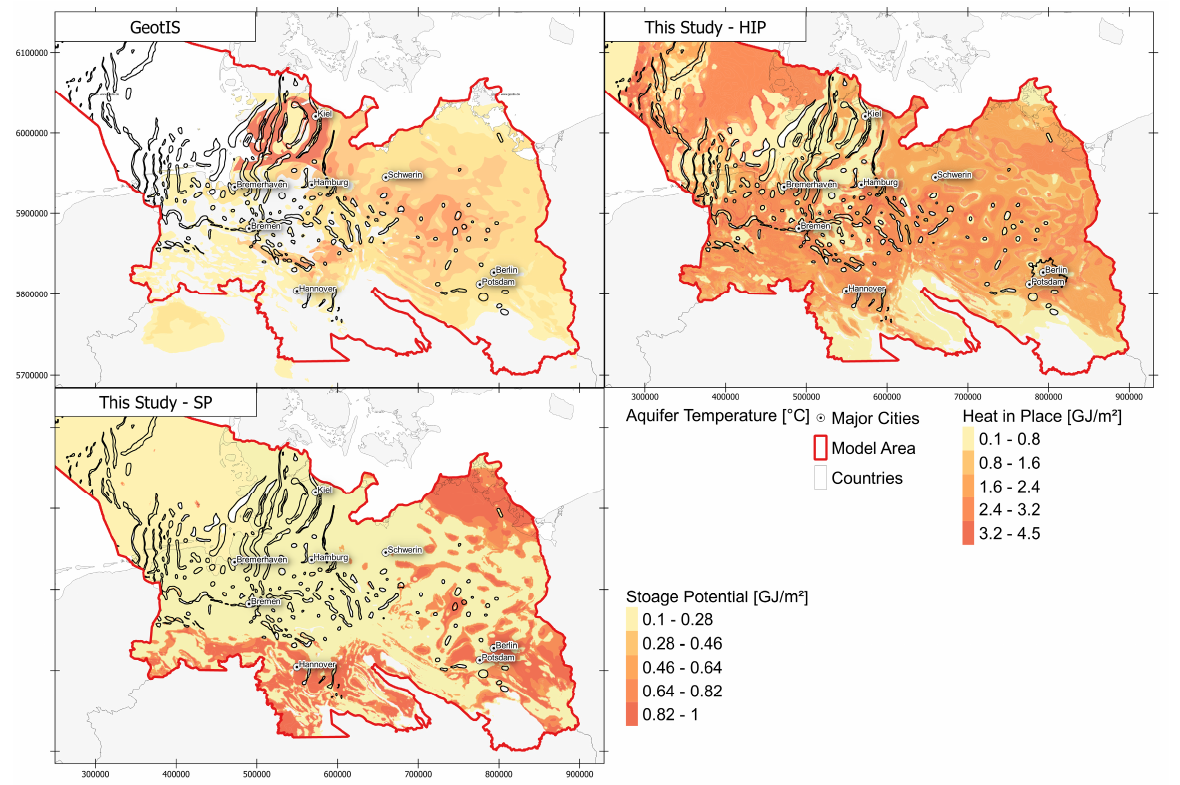
Figure 8. Comparison of geothermal target areas as published by Agemar and coauthors [46] compared to the ones calculated in this study. HIP = heat in place, HSP = storage potential. Color- coding indicated in the lower right. Note that Agemar and coauthors [46] show areas where any single reservoir at any depth exceeds a certain temperature threshold. This means that at any location in the map, there is at least one reservoir with a temperature higher than that of the indicated color. The two panels showing the results from this study take a similar approach, showing areas where the highest individual HIP or HSP is reached in any of the five reservoirs under study. Coordinates are in UTM Zone